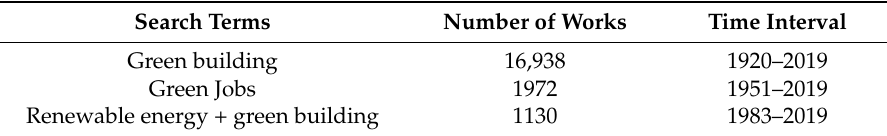
Table 1. Works retrieved from Scopus database.